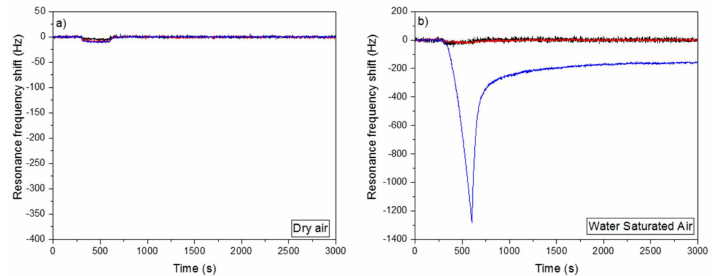
Figure 6. Response of a raw (black), a Cu(OH) 2 nanostructured (blue) and a CuO nanostructured